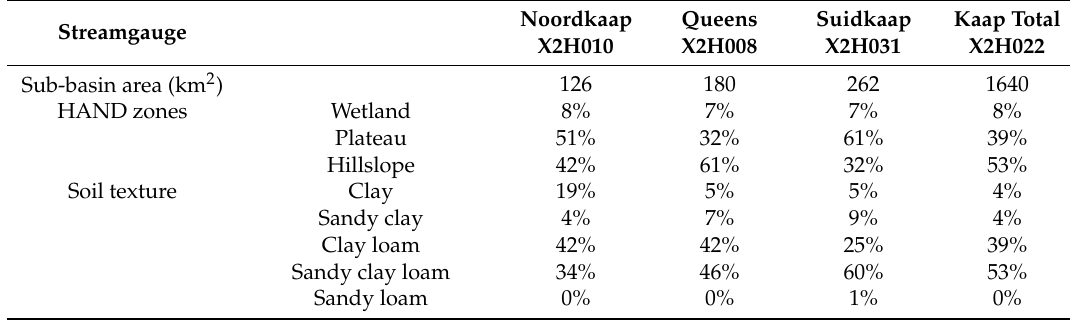
Table A1. Physiographic and hydroclimatic characteristics of Kaap catchment and tributaries.